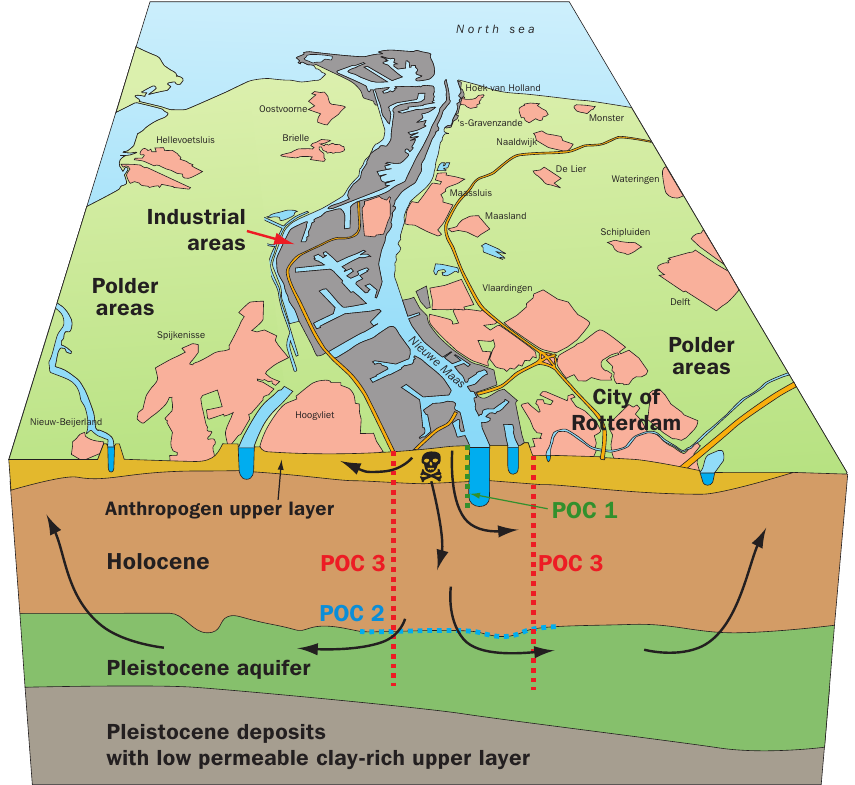
Figure 1. Schematic representation of the port of Rotterdam area with three main geologic layers: (i) Holocene clay and peat layer with sandy deposits ( ≈ 20m thick), (ii) Pleistocene layer with coarse sand ( ≈ 10m thick) and (iii) Pleistocene clay layer ( ≈ 30m thick). POC1, POC2 and POC3 refer to different planes of compliance at the port